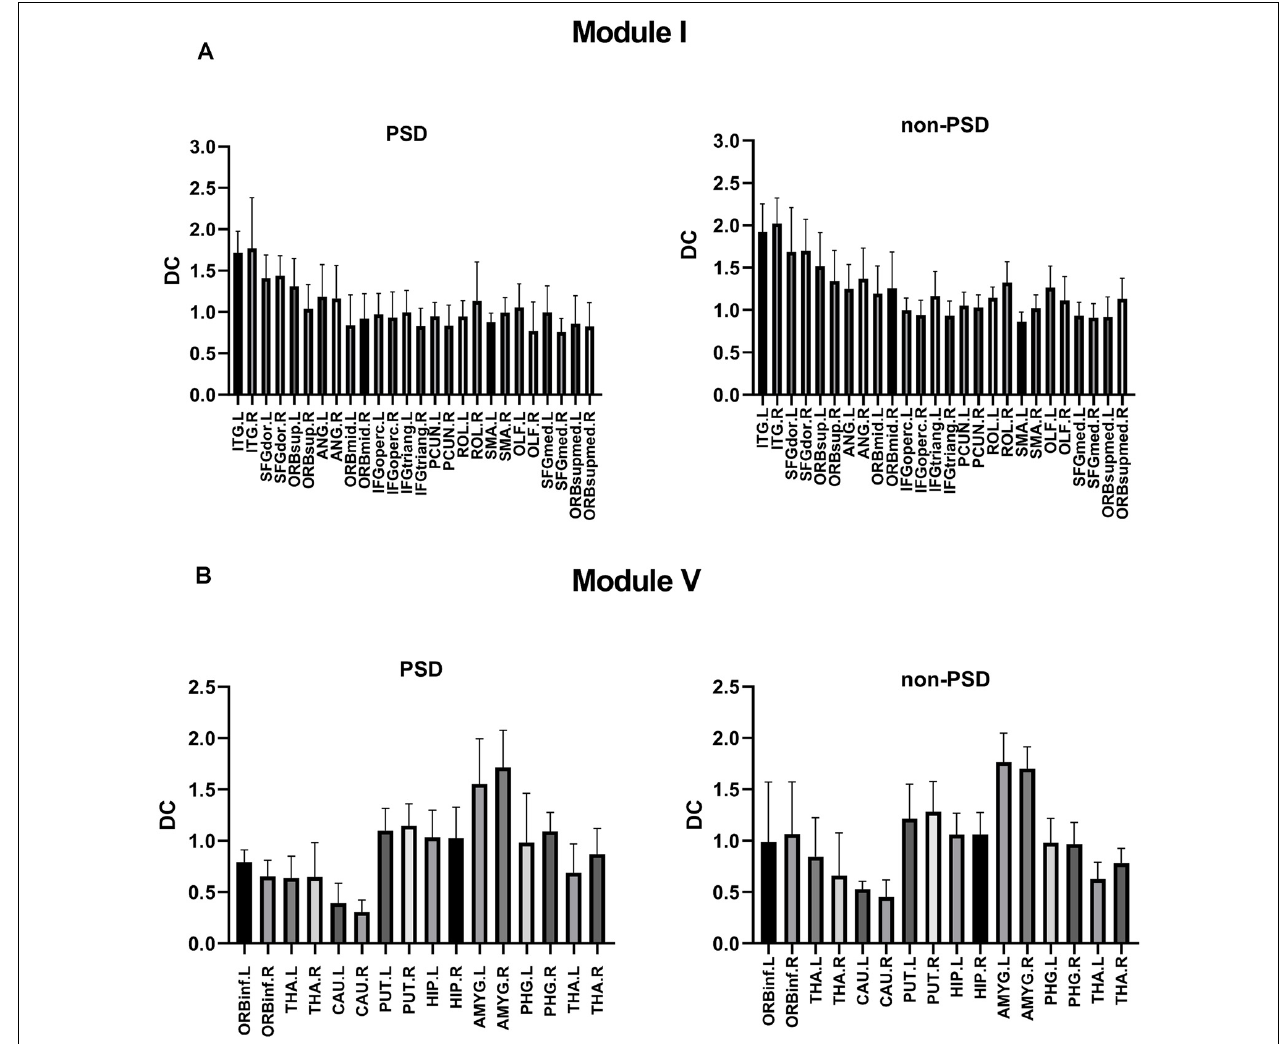
FIGURE 5 | (A) Comparison of the DC values of Module I in the PSD group and the non-PSD group ( p = 0.029, t = 1.456, FDR correction). (B) Comparison of the DC values of Module V in the PSD group and the non-PSD group ( p = 0.038, t = 2.126, FDR